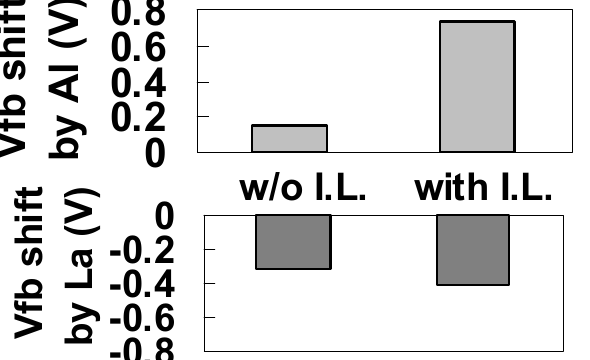
Figure 39. Bar graphs illustrating the maximum Vfb shift induced by ( a ) Al and ( b ) La relative to the intrinsic value for SiO Mo/La-Al-O/Si (w/o I.L.) gate